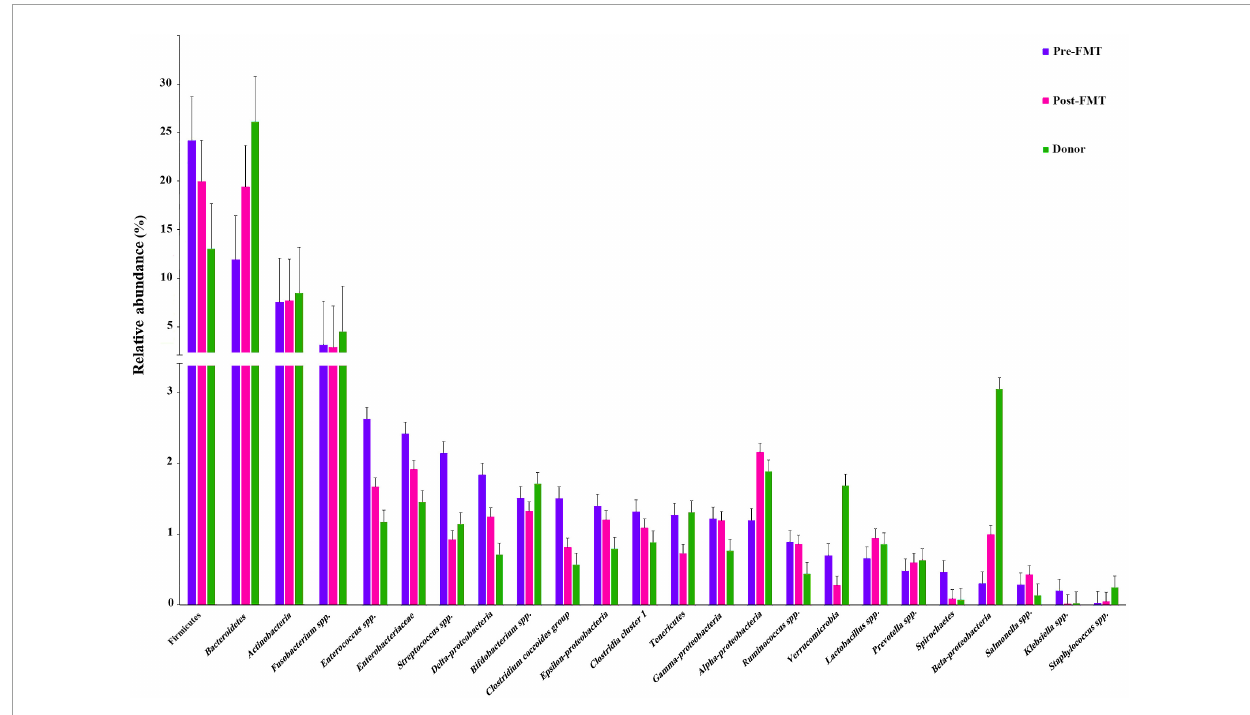
FIGURE2 Bar-plot analysis of the relative abundance and distribution of each targeted gut microbiota in fecal samples of healthy donors, and patients before (pre-FMT) and after (post-FMT) fecal microbiota transplantation (FMT). Data are presented as mean ±